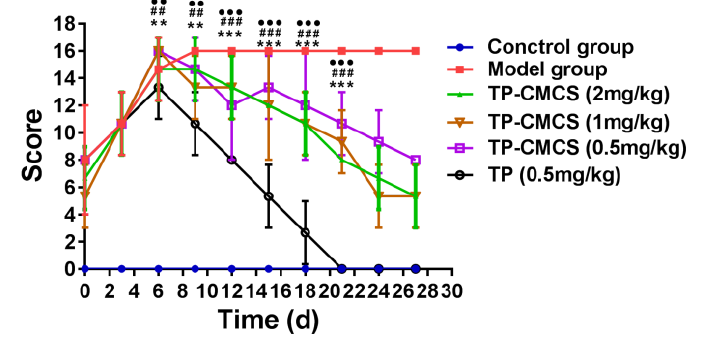
Figure 8. The changes of arthritis scores of the CIA mice during the process of administration. ** Represents p <0.01, *** represents p <0.001 vs TP (0.5mg/kg); ## represents p <0.01, ### represents p <0.001, vs TP (0.5mg/kg); ●● represents p <0.01, ●●● represents p <0.001 vs TP (0.5mg/kg).